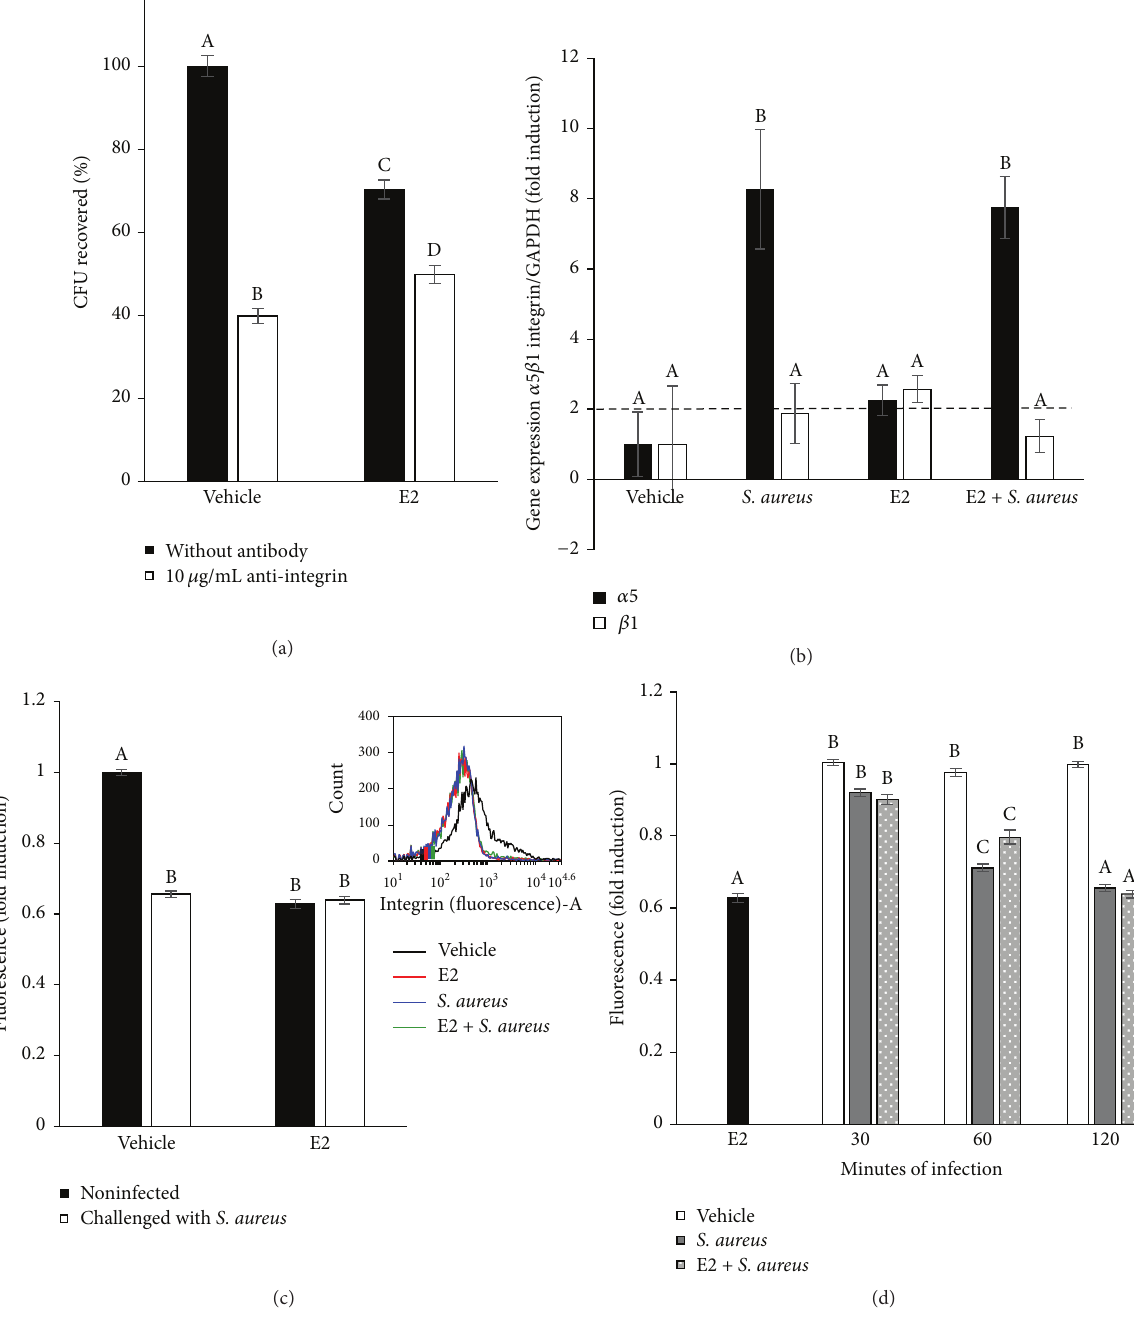
Figure 3: Role of 𝛼 5 𝛽 1 integrin during the internalization of S. aureus into bMECs inhibited with E2. (a) Primary cultures of bMECs treated for 24 h with E2 (50 pg/mL) were incubated with 10 𝜇 g/mL of a specific blocking antibody against 𝛼 5 𝛽 1 integrin for 1h and then challenged with S. aureus (MOI 30 : 1 bacteria per cell). The number of internalized bacteria is represented by the ratio of CFU/bMEC recovered after lysis of bMECs. (b) The 𝛼 5 𝛽 1 mRNA expression was analyzed by RT-qPCR and GAPDH was used as endogenous gene in all conditions. Fold-change values greater than 2 or less than 0.5 were considered as significant differentially expressed mRNAs. Each bar shows the mean of triplicates ± SD of three independent experiments. (c) The relative fluorescence intensities of 𝛼 5 𝛽 1 membrane abundance in bMECs treated with E2 and infected with S. aureus are shown. Fluorescence intensity was estimated from 10,000 events. An inserted histogram plot that shows 𝛼 5 𝛽 1 staining data in vehicle-treated bMECs (black line), cells that were challenged with S. aureus (blue line), cells that were stimulated with E2 (red line), and E2-treated bMECs infected with S. aureus (green line). The cells were fixed and stained extracellularly with an anti- 𝛼 5 𝛽 1 antibody overnight and analyzed by flow cytometry. (d) The abundance of 𝛼 5 𝛽 1 integrin in the bMEC membrane determined as the mean of the fluorescence of challenged bMECs at different times of infection with the same MOI (30 :1 bacteria per cell). A total of 10,000 events were measured. Different letters indicate significant changes among treatments ( 𝑃 < 0.05 ), except for (b), where different letters above the bars indicate significant changes among the four treatments within the same gene evaluated ( 𝑃 < 0.05 ). Vehicle: 1%